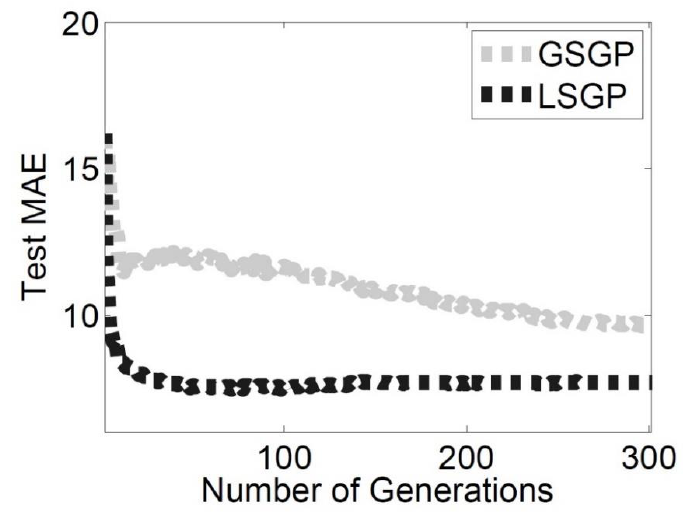
Figure 3. Test MAE. The plots show the median over 100 runs. The Test MAE is expressed in Euros. The light gray line represents Geometric Semantic Genetic Programming, while the black line represents Geometric Semantic Genetic Programming with Local Search.